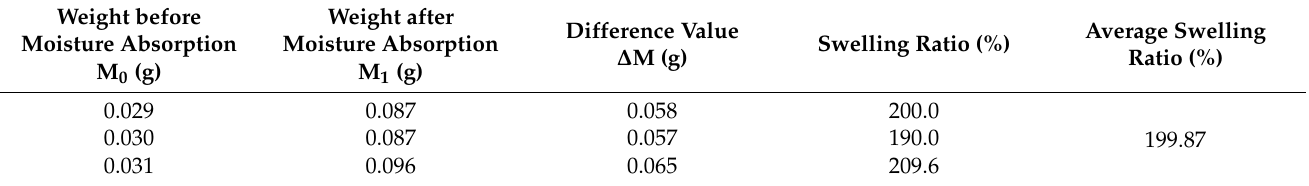
Table 2. Swelling ratios of PN@8 wt%Ag-2 h (experimental